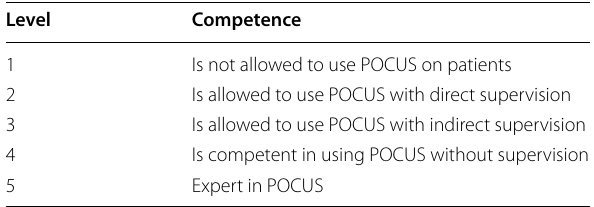
Table 1 Different competence levels for POCUS in acute internal